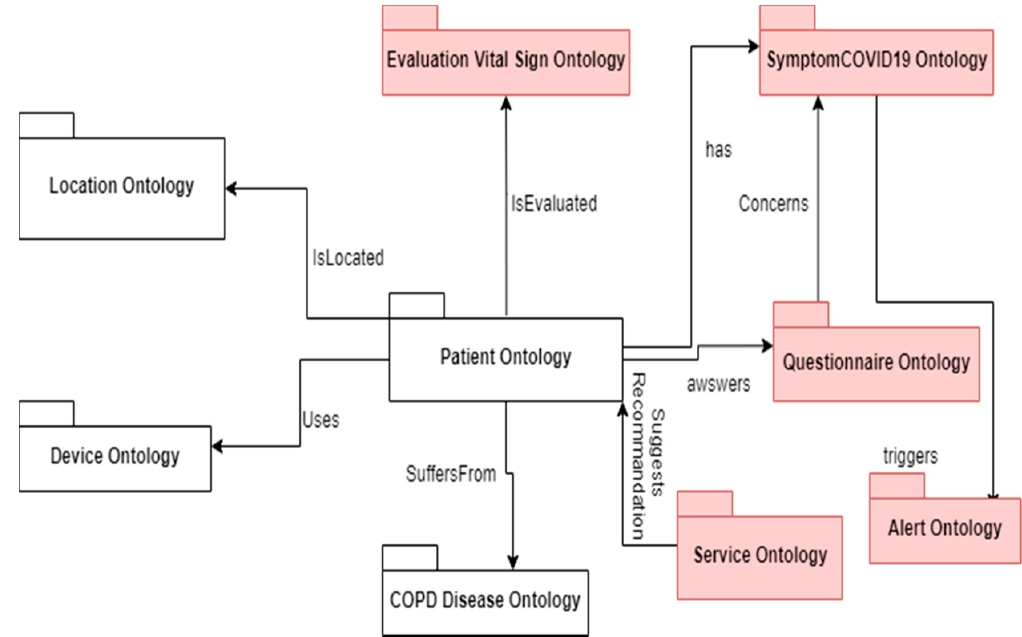
Figure 7. SuspectedCOPDcoviDOlogy overview.